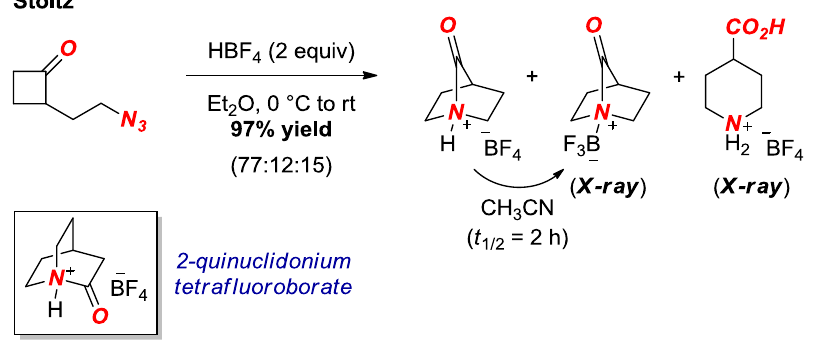
Figure 6. Synthesis of 7-Hypoquinuclidonium Tetrafluoroborate.